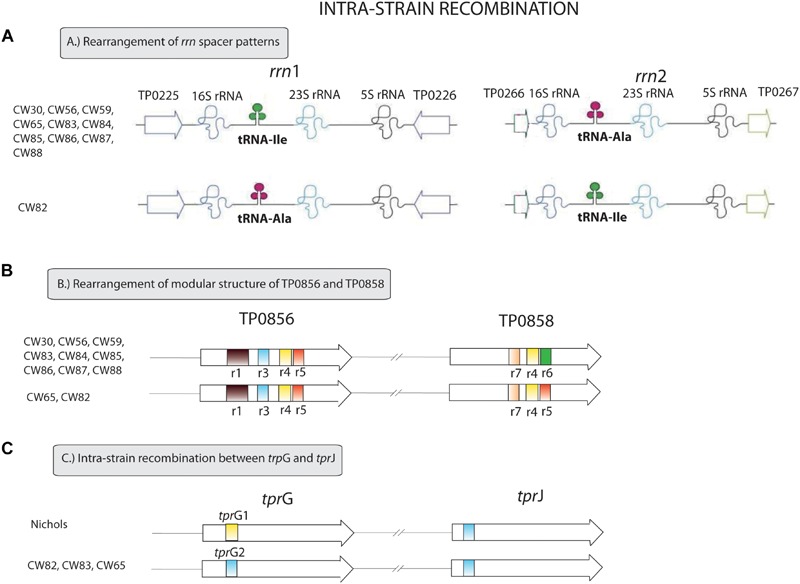
Intra-strain recombination events found among examined clinical samples. (A) Rearrangement of rrn spacer patterns. The ribosomal operon with Ile/Ala tRNA patterns differ from the ribosomal operon with Ala/Ile tRNA patterns in 34 nucleotide positions. The figure was modified according to Čejková et al. (2013). (B) Rearrangement of the modular structure of TP0856 and TP0858 genes. We identified two variants of the modular structure of the TP0856 and TP0858 genes – r1r3r4r5/r7r4r5 and r1r3r4r5/r7r4r6. These structures differ in 30 nucleotide sites. The figure was modified according to Strouhal et al. (2018). (C) Intra-strain recombination between tprG and tprJ. tprG1 and tprG2 allele variants differ in 18 variable positions.